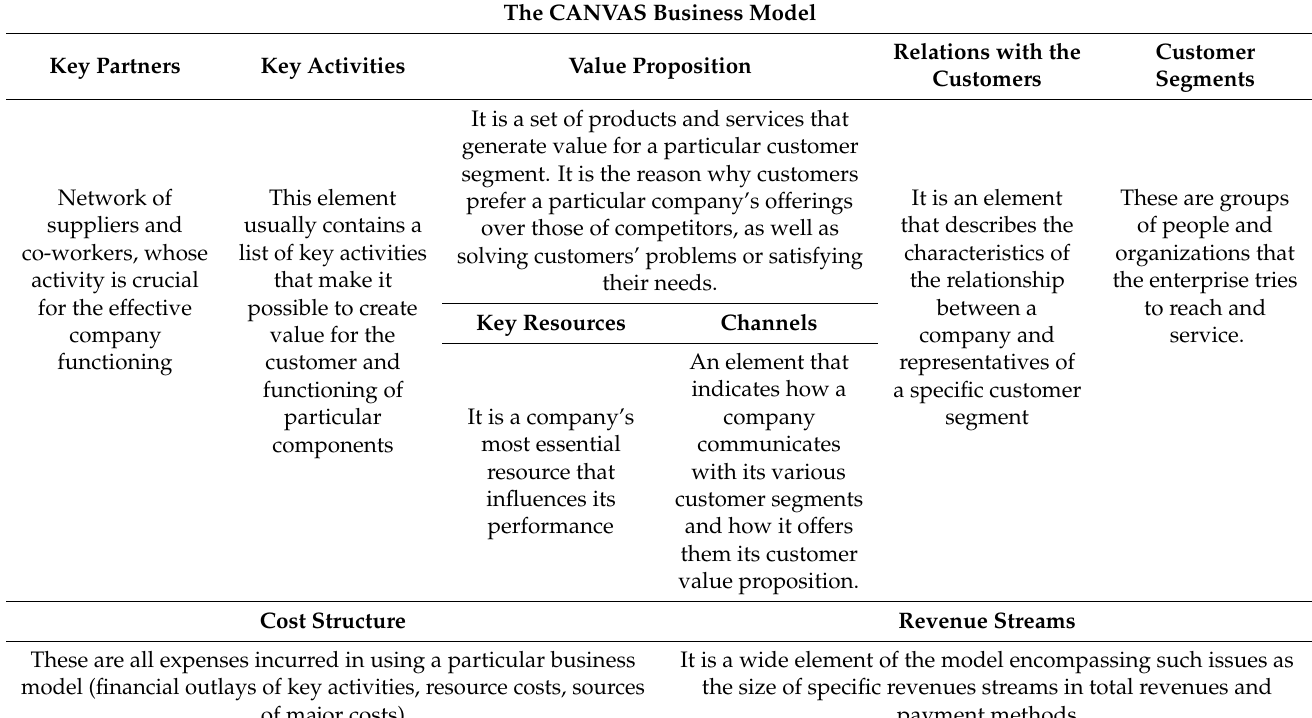
Table 1. The CANVAS business